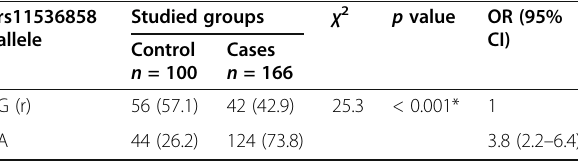
Table 7 rs11536858 allele distribution between cases and control